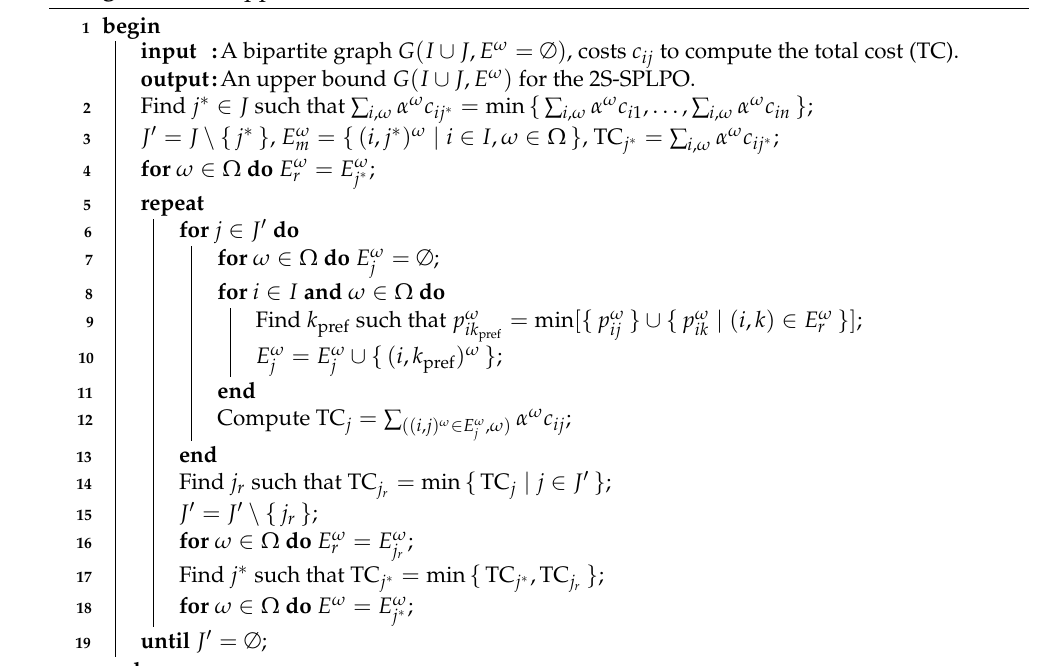
Algorithm 2: Upper bound heuristic for the